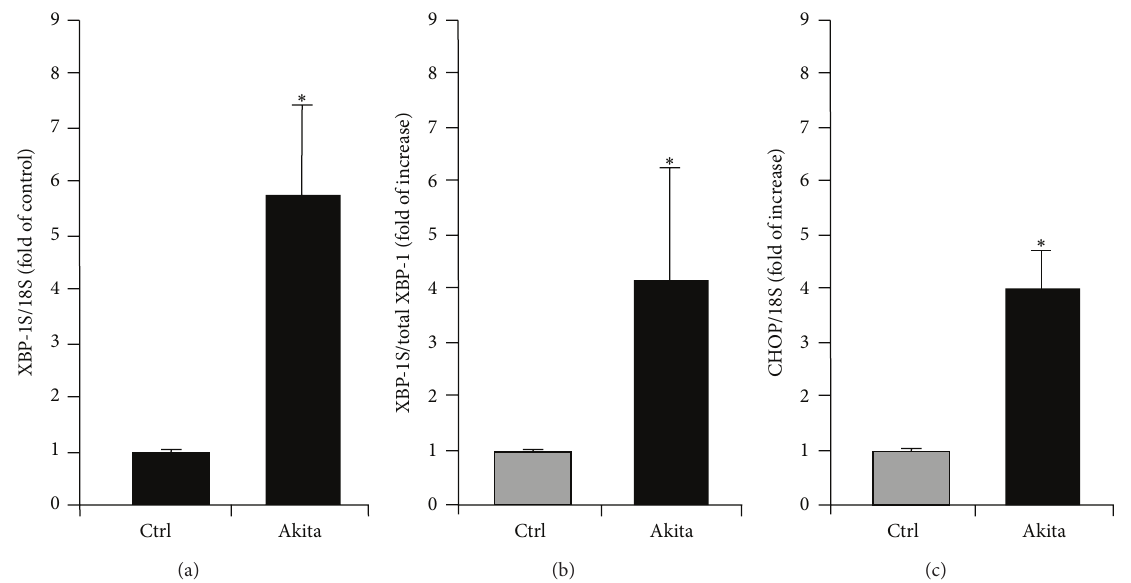
Figure 2: Increase in XBP1 mRNA splicing and CHOP expression in diabetic retinas. mRNA expression of spliced XBP1, total XBP1, and CHOP in retinas from 6-month-old Akita mice were determined by qRT-PCR. The values were normalized by 18S ribosome RNA and expressed as mean ± S.D. ( 𝑛 = 7 in control group and 𝑛 = 4 in Akita group). ∗ 𝑃 < 0.01 versus